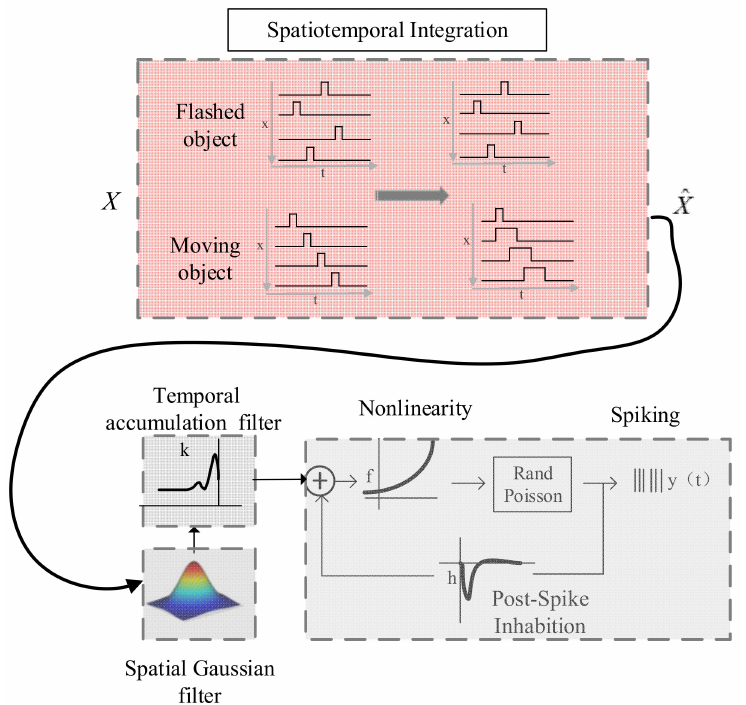
Figure 5. Schematic of the model structure. This model was based on Generalized Linear Model framework by adding a spatiotemporal integration module to stimulus filters. The spatiotemporally correlated stimulus input was firstly transformed into a temporally correlated stimulus. The outputs of three filters (a spatial filter, a temporal filter and a post-spike filter) were summed and passed through a nonlinear function f to determine the conditional intensity. Finally, spikes are generated via a conditionally Poisson